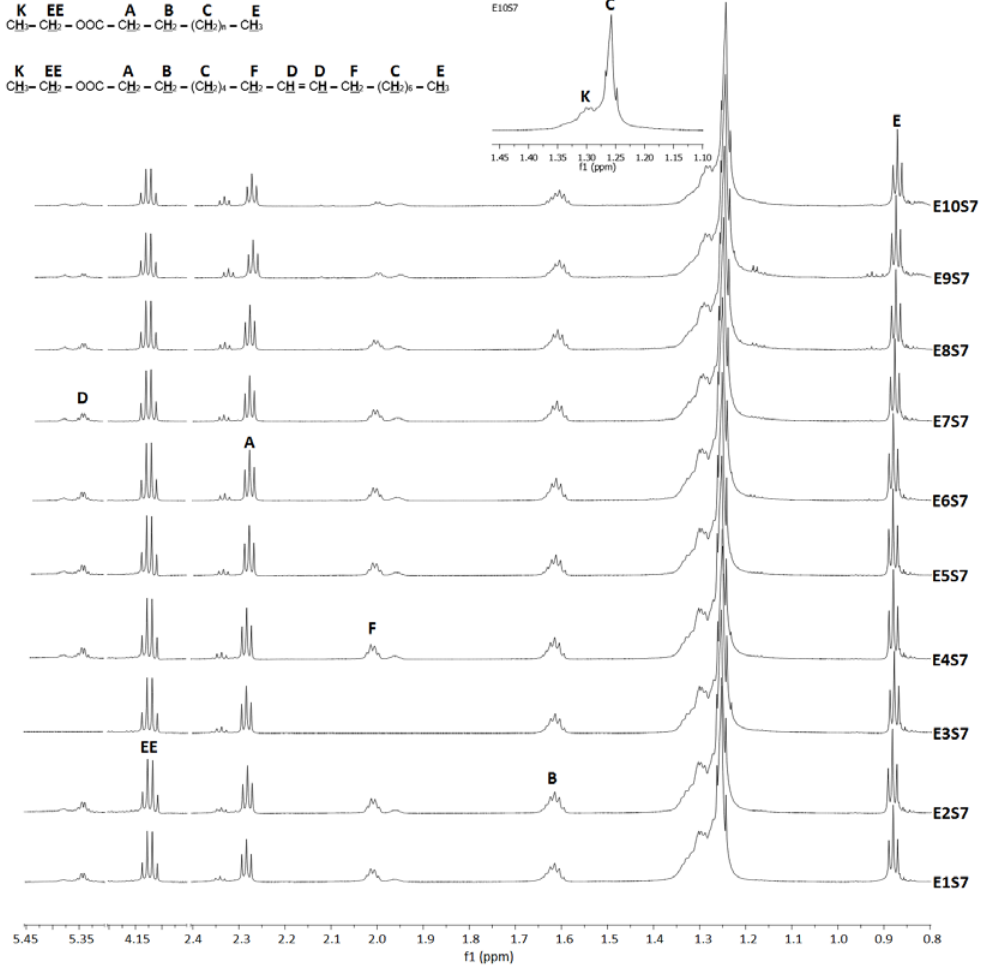
Figure 1. 1 H-NMR spectra for FAEE obtained from beef tallow by using supercritical ethanol. Yield for FAEEs ( 𝑌𝑌